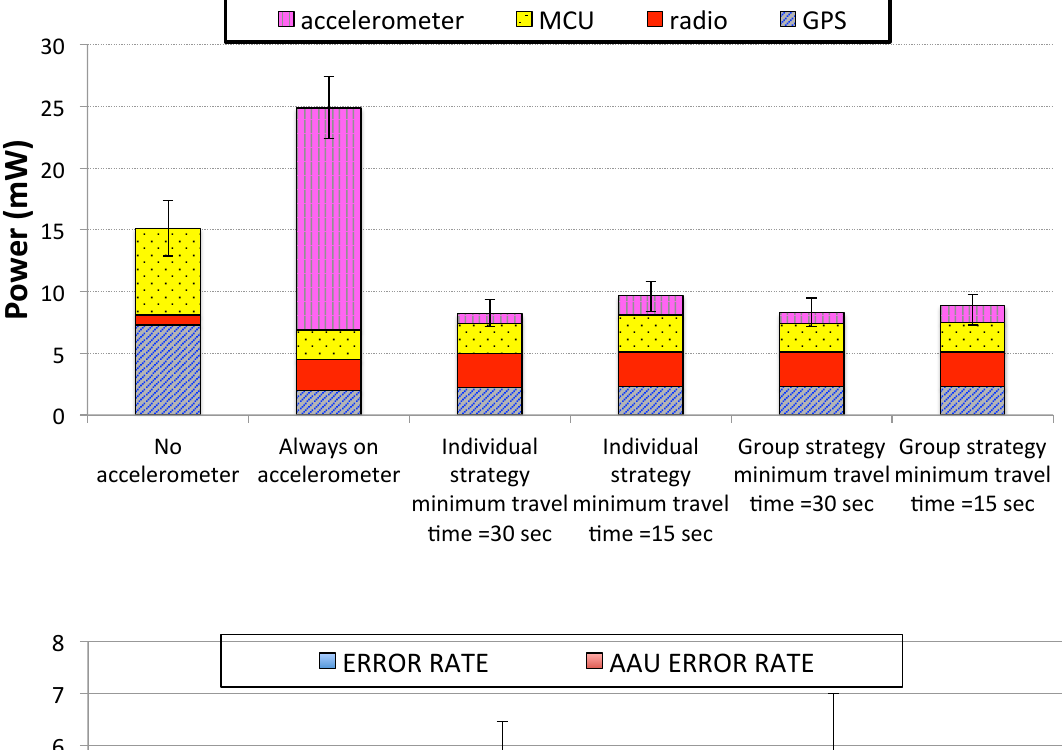
Figure 21. Performance comparison of the three strategies over the entire